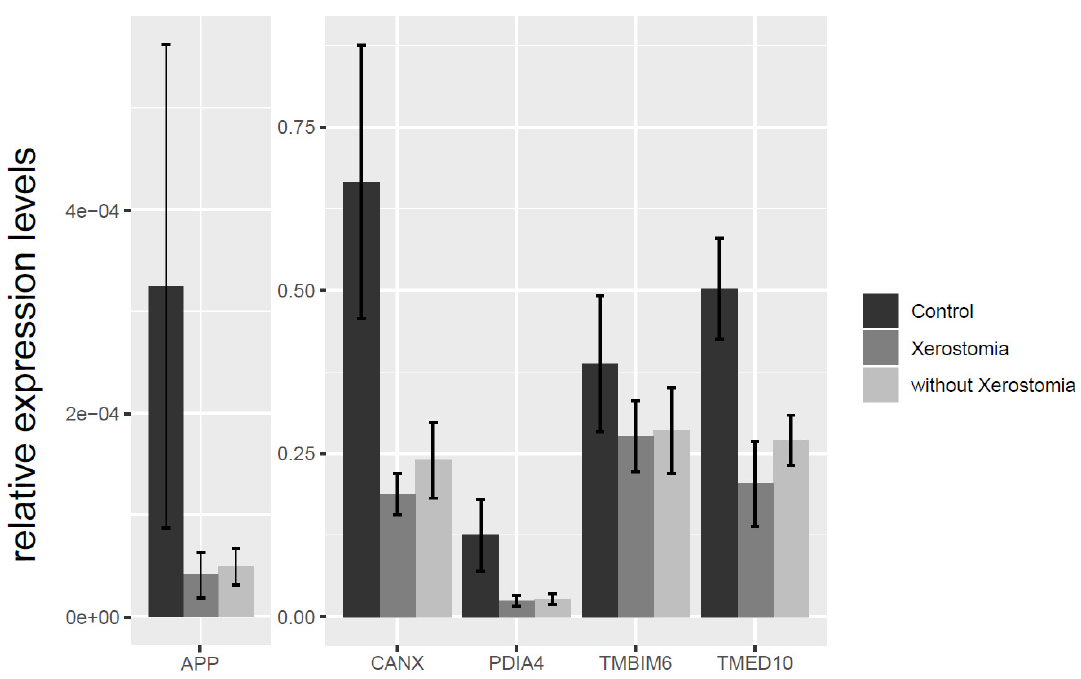
Figure 3. Comparison of APP, TMBIM6, TMED, CANX, and PDIA4 relative gene expression between healthy control subjects (HS), SS patients with xerostomia SS (sicca) and SS patients without xerostomia SS (non-sicca).